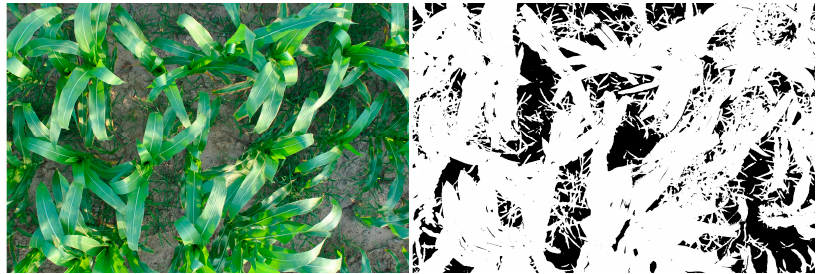
Figure 2. An example of the photos ( Left ) taken in the field and the corresponding segmentation ( Right ) of green vegetation (white) and non-green vegetation pixels (black).